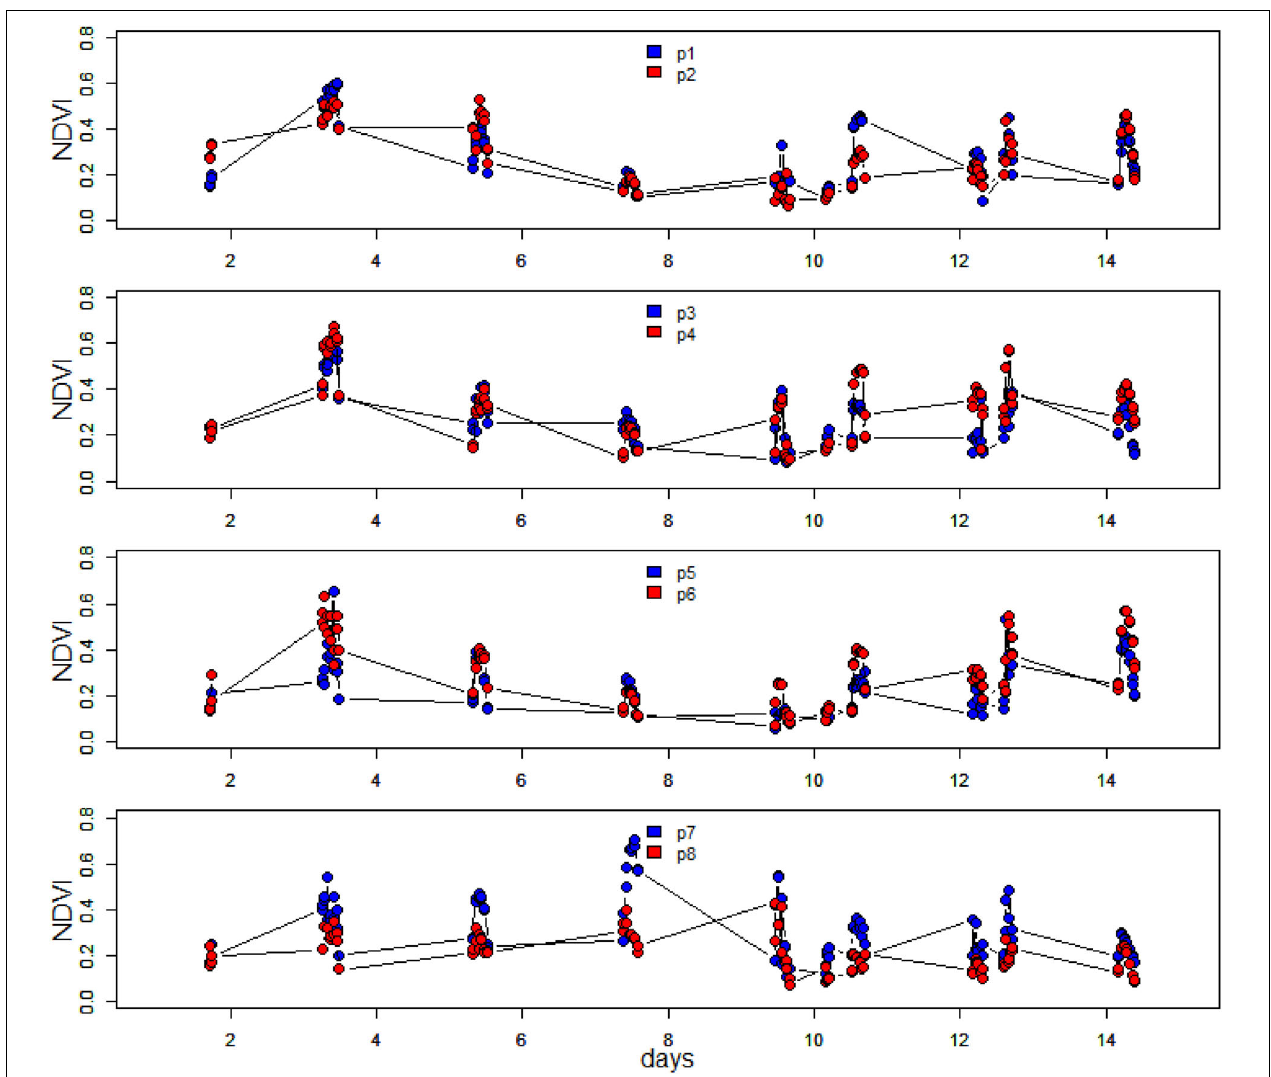
FIGURE 4 | Time series of hourly averaged NDVI over the spring-neap-spring measuring period at the eight different positions along the 1-m transect. The site was sampled every 2